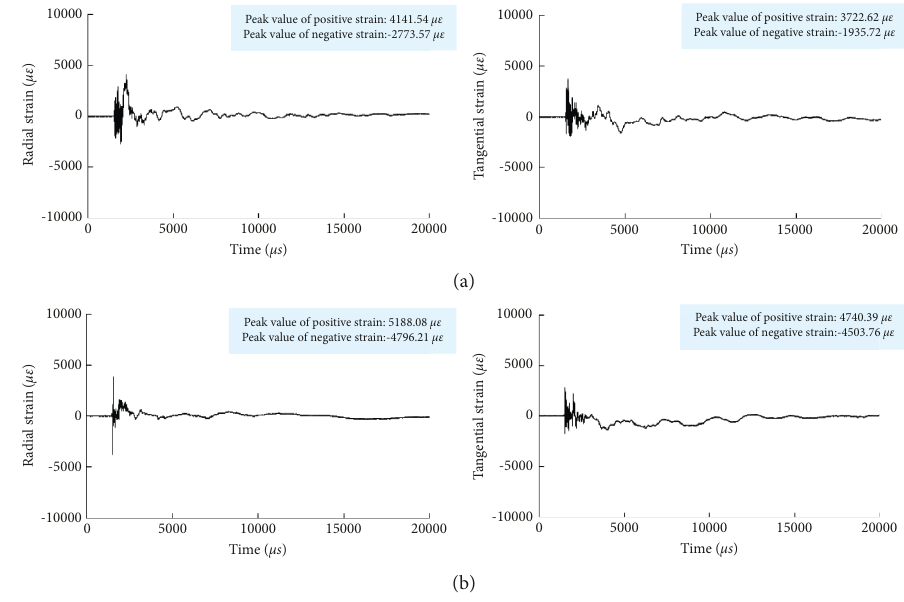
Figure 28: Explosion strain time history curves for case SN